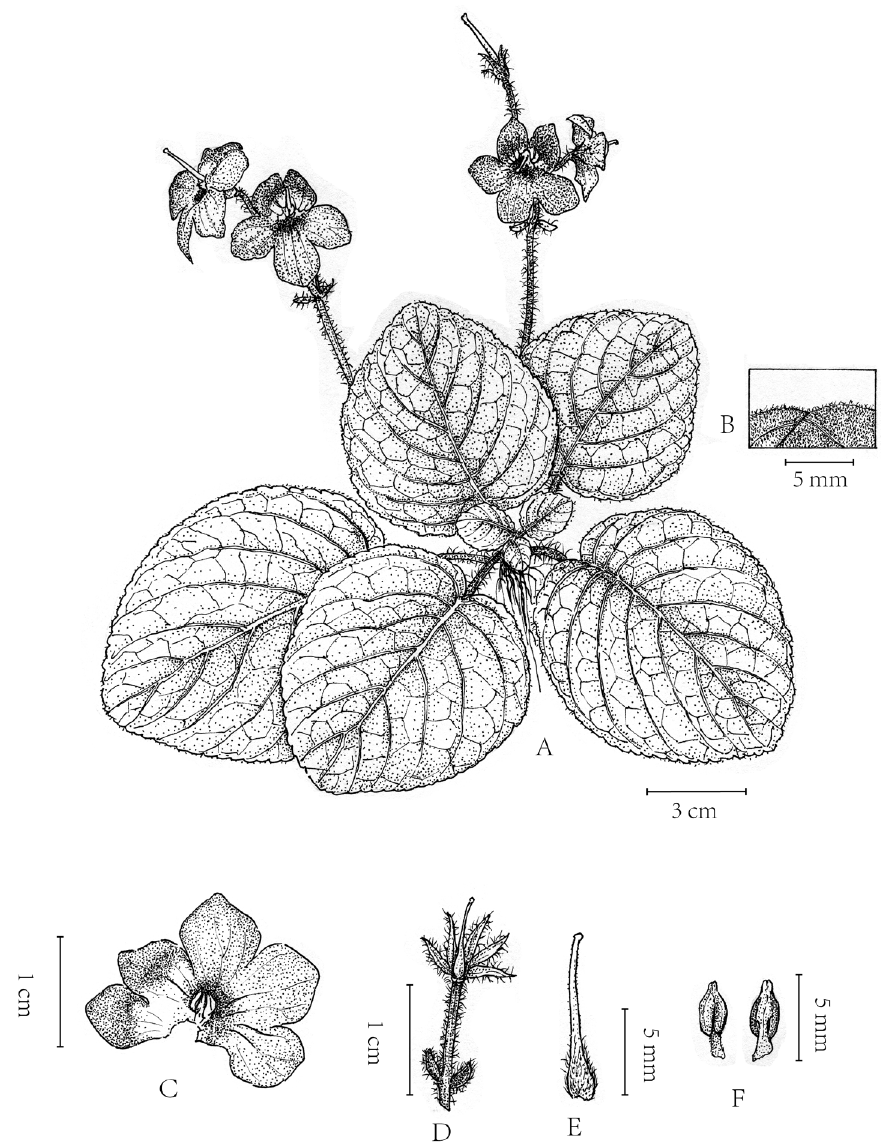
Figure 4. Petrocosmea tsaii Y.H.Tan & JianW.Li, sp. nov. A Habit B adaxial Leaf surface indumentum C corolla (Dissected) D pedicel with bracteoles, calyx and pistil E pistil F stamens. Drawn by Zheng- meng